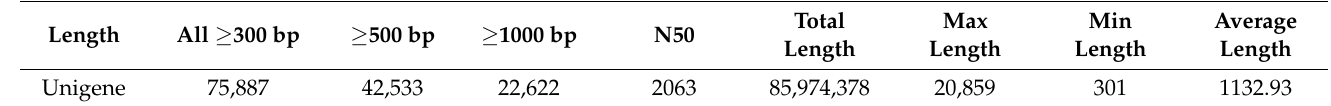
Table 2. The sequencing results from the testes and the ovary of M. rosenbergii